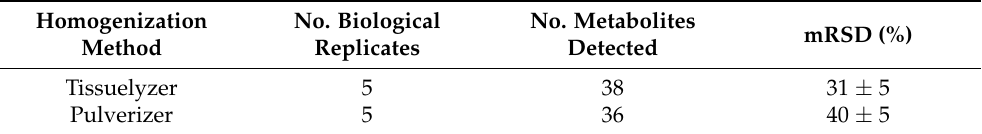
Table 1. Comparison of repeatability (median standard deviation = mRSD) and sensitivity (number